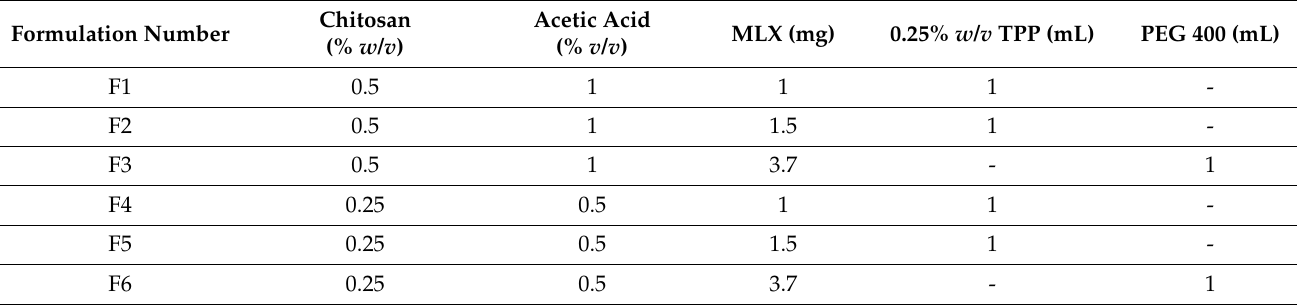
Table 2. Compositions of the prepared